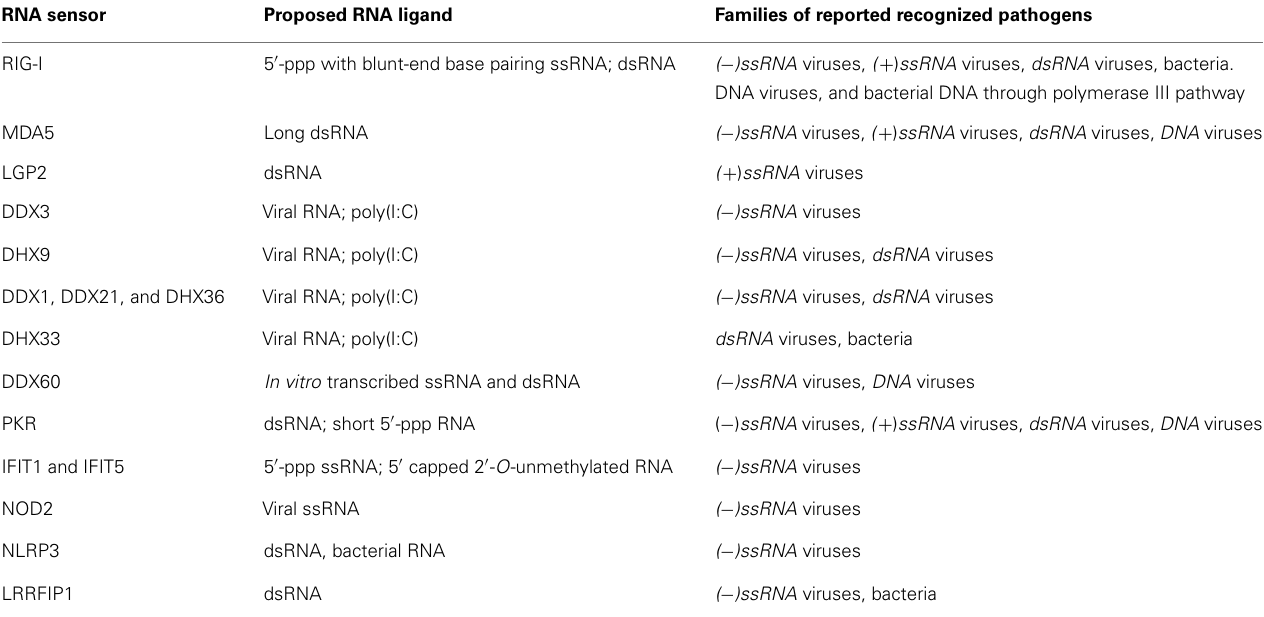
Table 1 | Cytosolic RNA sensors and their ligands . RNA sensor Proposed RNA ligand Families of reported recognized